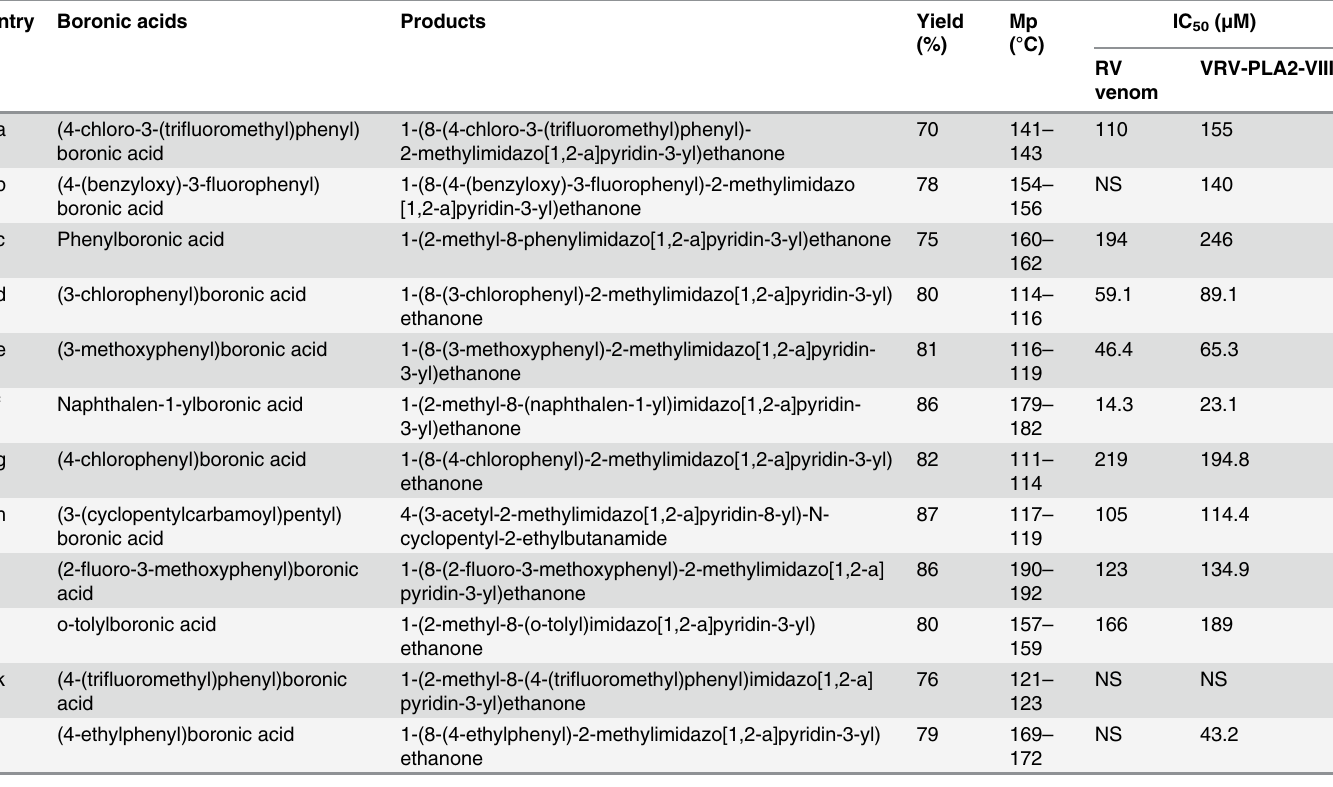
Table 1. Physical data of the tri-substituted-condensed-imidazopyridines and IC 50 values towards the binding of PLA 2 . Entry Boronic